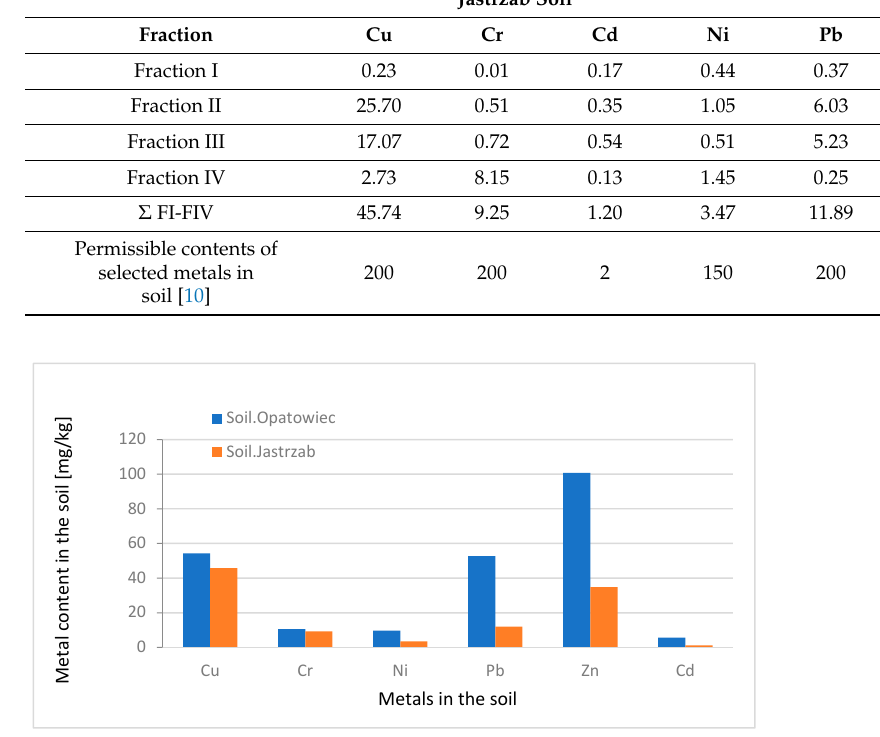
Table 4. Chemical speciation of heavy metals in the soil from Jastrzab in Mazowieckie Voivodship (mg/kg). Table 5. Percentage % of heavy metals of the FI and FII fraction in the Jastrzab and the Opatowiec soils in relation to the total content of ∑ FI ‐ FIV metals.